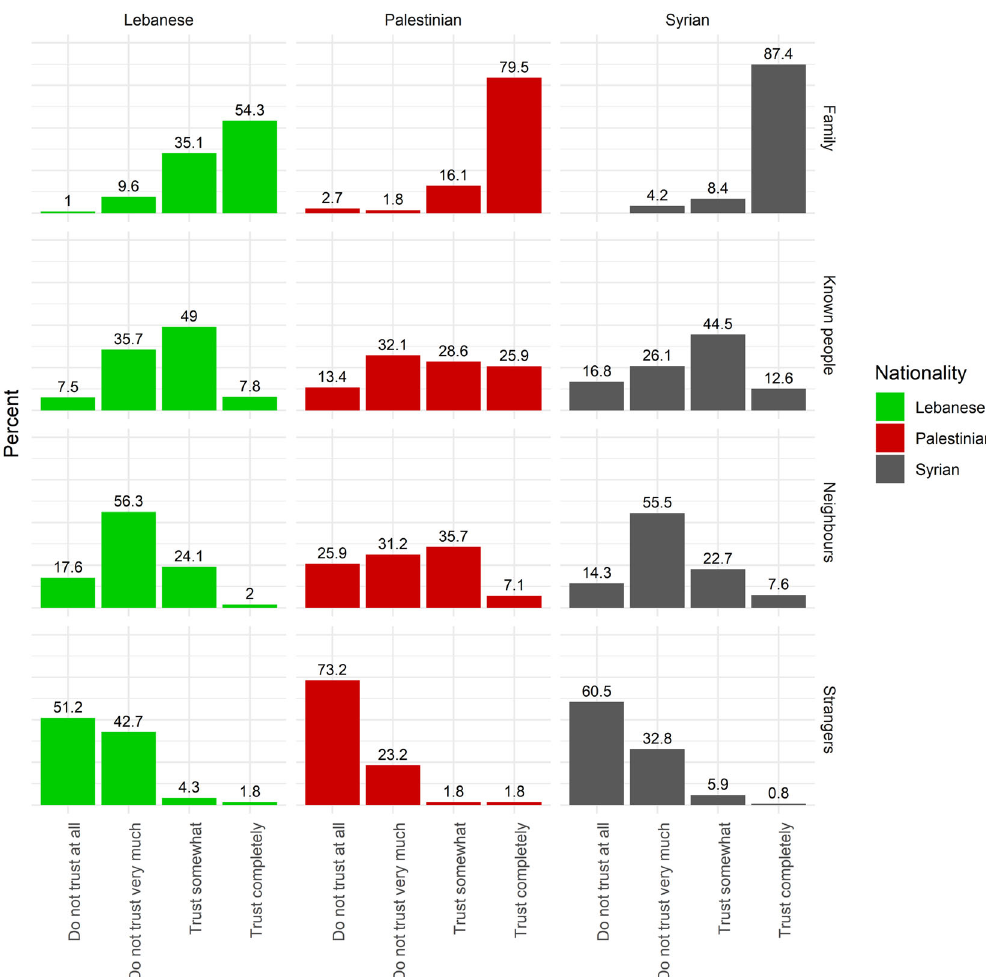
Fig. 7 Trust by nationality and domain. Bars represent response proportions for each trust